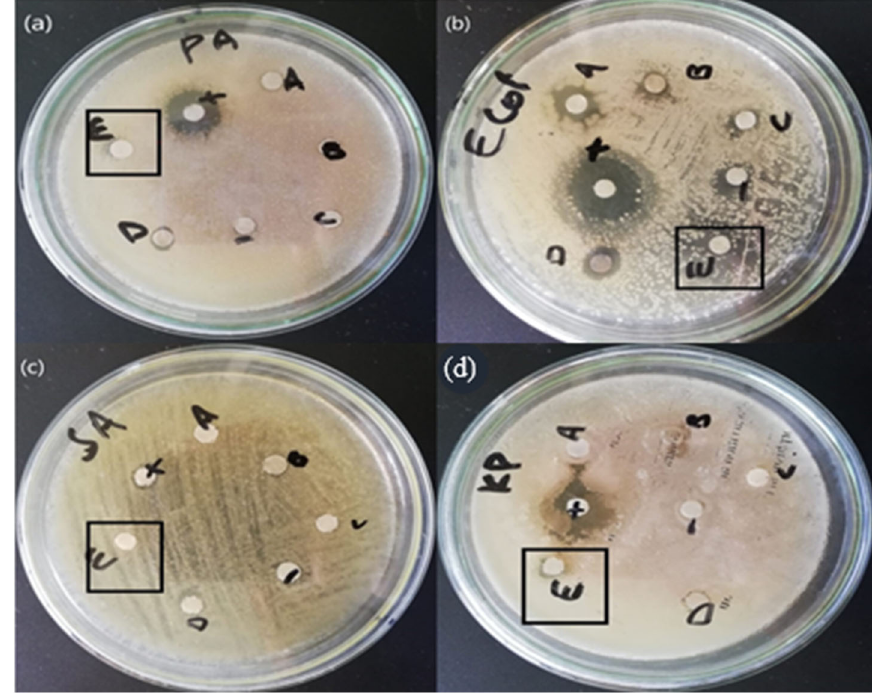
Figure 7. ( a ) P.aeuroginose ( b ) E. coli ( c ) S.aeururs ( d ) K.pneumonia Antibacterial activity of the zinc Figure 7. ( a ) P. aeuroginose ( b ) E. coli ( c ) S. aeururs ( d ) K. pneumonia Antibacterial activity of the zinc oxide nanoparticles. oxide nanoparticles.